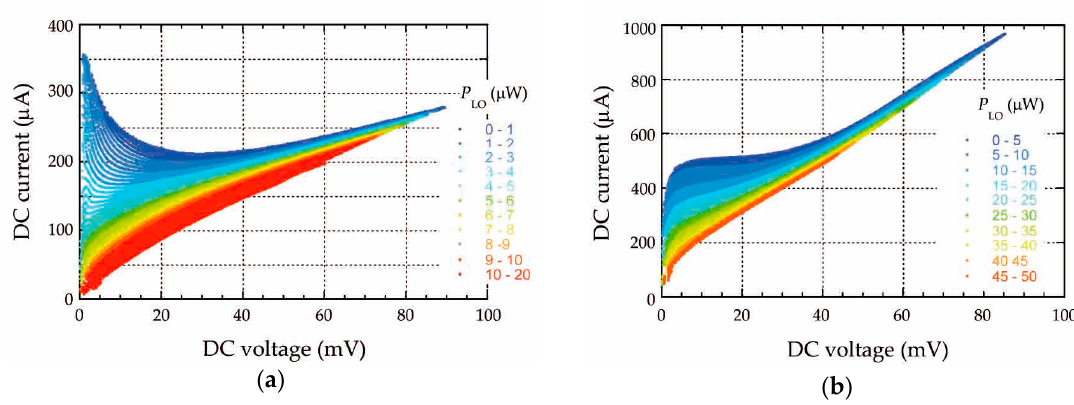
Figure 5. For devices A and B, DC current vs. DC voltage maps according to P LO values, at 400 GHz LO frequency: ( a ) For device A ( T 0 = 60 Κ ); ( b ) for device B ( T 0 = 70 Κ ). Redrawn after [45].